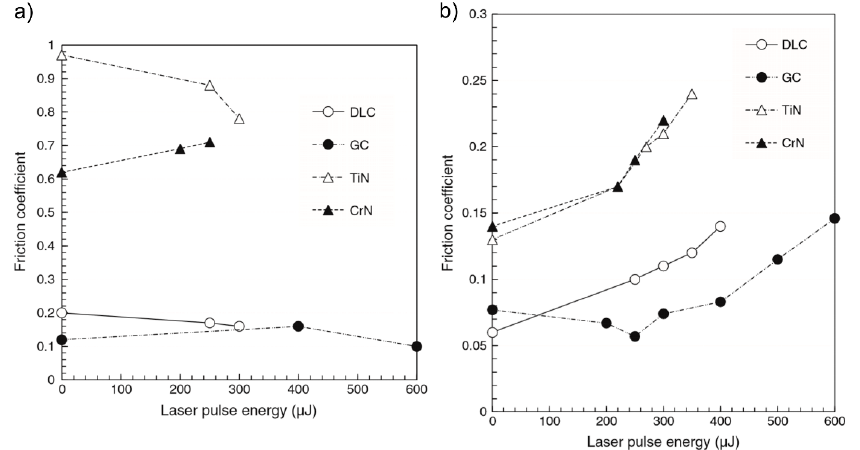
Figure 18. Friction coefficients of DLC, GC, TiN and CrN measured as a function of laser pulse energy using ( a ) a load of W = 2 N and a steel ball and ( b ) an ultralight load of W = 1.5 mN and a diamond tip. Reprinted from Yasumaru et al . [142], Copyright 2011, with permission from Elsevier.